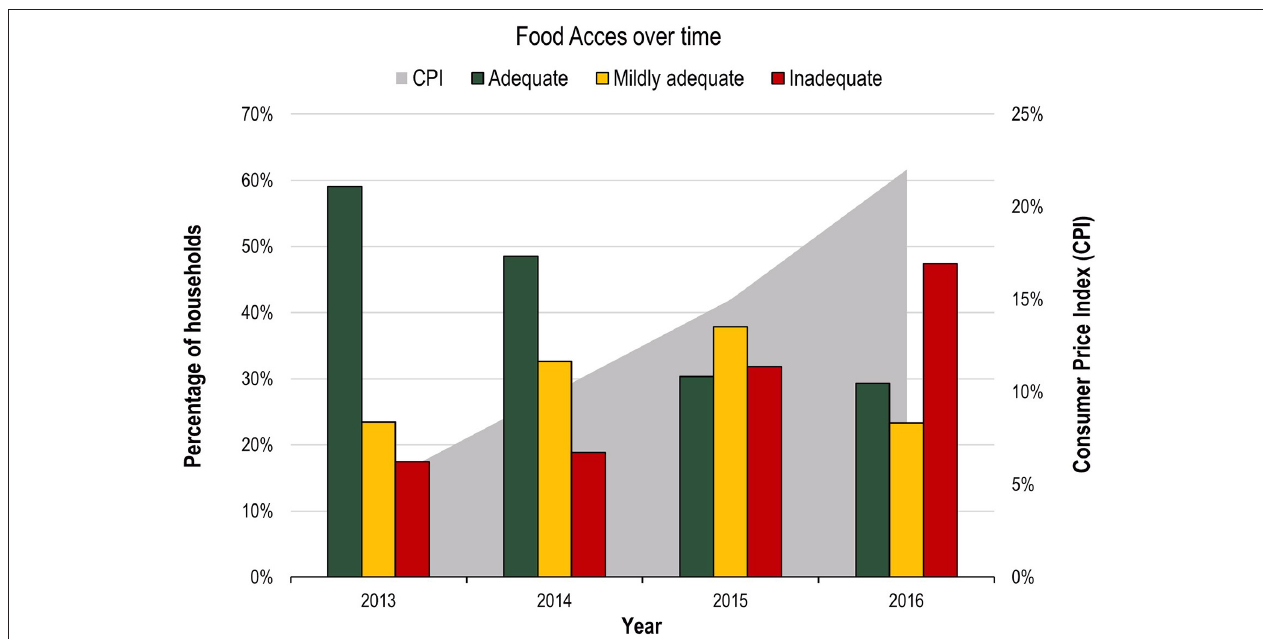
FIGURE 2 | The perceived state of household food access in respondent household, from 2013 to 2016 and the calculated cumulative national Consumer Price Index change across the same period–2013–2016 (CPI data retrieved from Stats SA